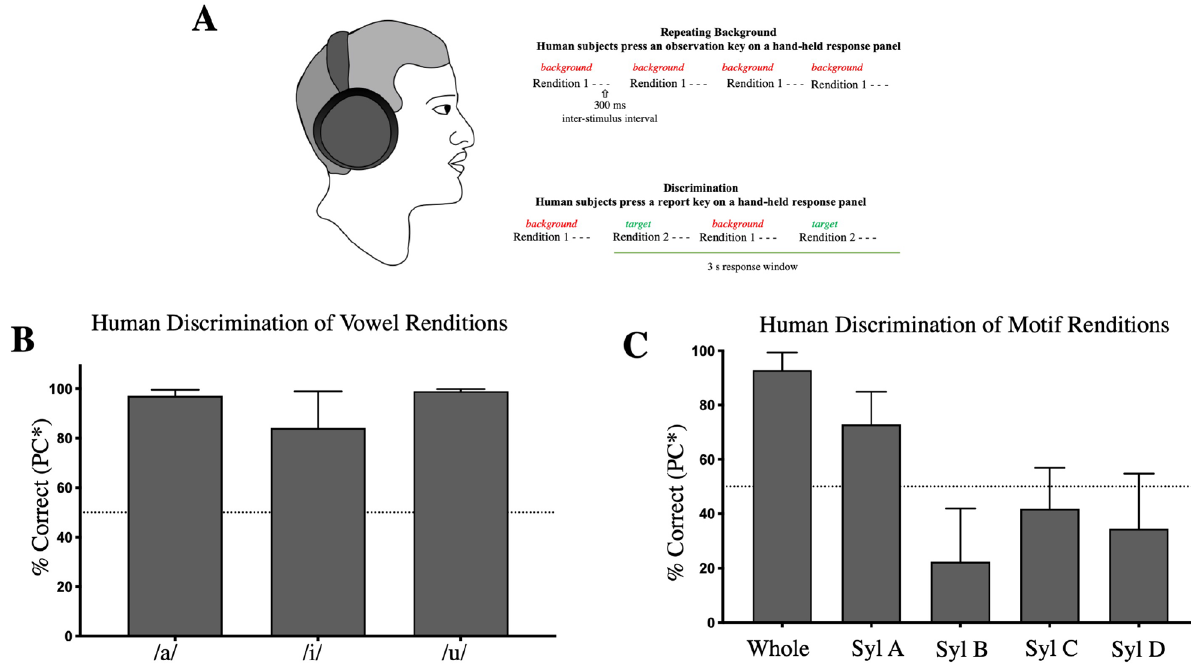
Figure 4. ( A ) Description of human psychophysical testing. Subjects were stationed at the same computers which controlled the bird operant tasks, outfitted with Sennheiser HD280PRO headphones, and given a response panel with two keys. Subjects were told they would be listening to a repeating background sound, during which they should press the observation key to cause a change in the background and to press the report key whenever they heard a change. ( B ) Performance (PC*, mean ± SEM, N = 3) on discriminating the different renditions of vowels from a single human speaker. ( C ) Performance (PC*, mean ± SEM, N = 3) on discriminating the different renditions of zebra finch